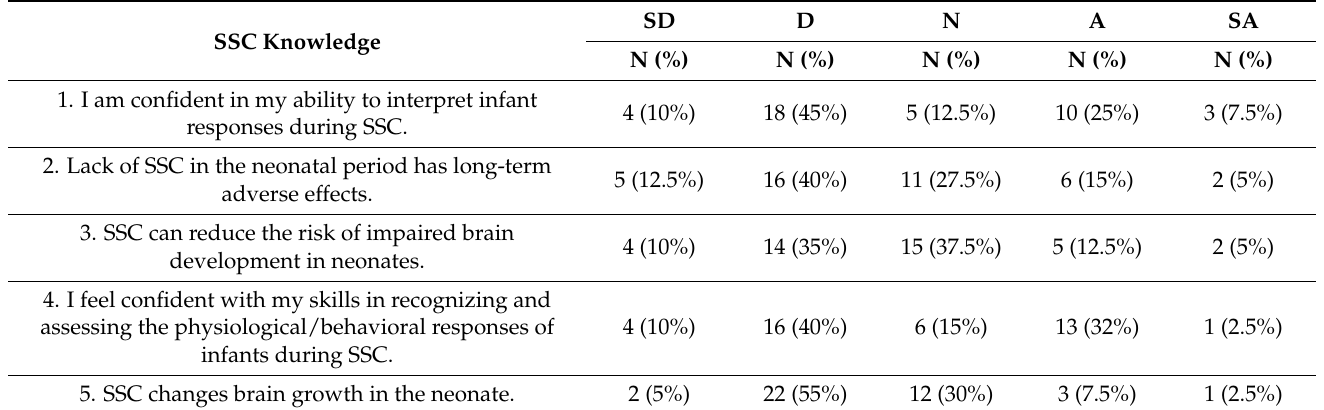
Table 1. Number and percentage of Likert-based responses on the nurses’ knowledge of SSC.